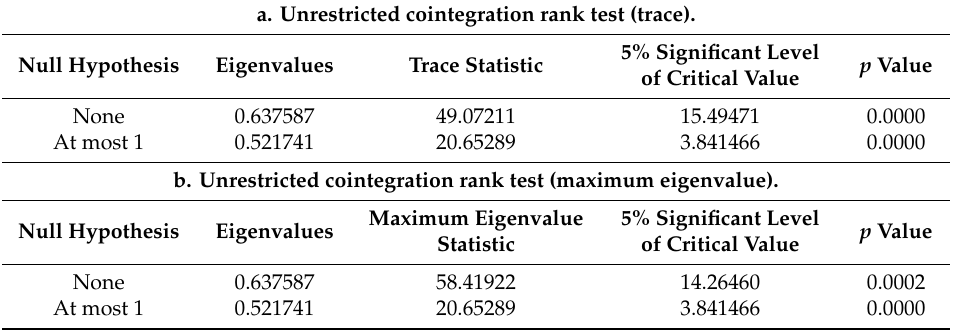
Table 2. Johansen cointegration test.